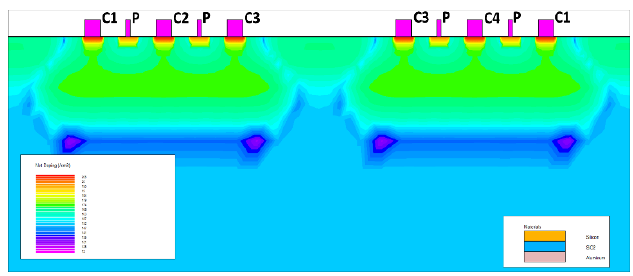
Figure 8. The double three-contact structure.